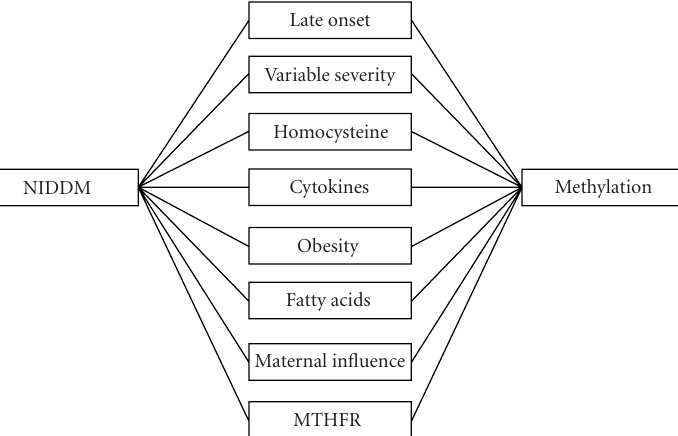
Figure 2. Important relationships shared by methylation and T2DM (referred to as “NIDDM” in the system). A total of 1287 co-cited objects were identified between the two, about 959 of these reflect actual relationships of a nontrivial nature. Only relationships emphasized within this report are shown here. A full list is available online at http://innovation.swmed.edu/ IRIDESCENT/NIDDM